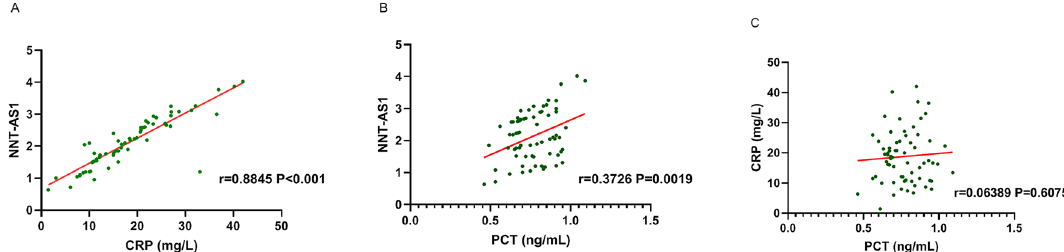
Figure 2. Correlations among LncRNA NNT-AS1, CRP and PCT. (A) Pearson correlation test showed that serum LncRNA NNT-AS1 was positively correlated with CRP expression (r = 0.8845, P < 0.001). (B) Pearson correlation test showed that serum LncRNA NNT-AS1 was positively correlated with PCT expression (r = 0.3726, P = 0.0019). C. Pearson correlation test showed that there was no linear correlation between CRP and PCT expression (r = 0.06389, P = 0.6075).